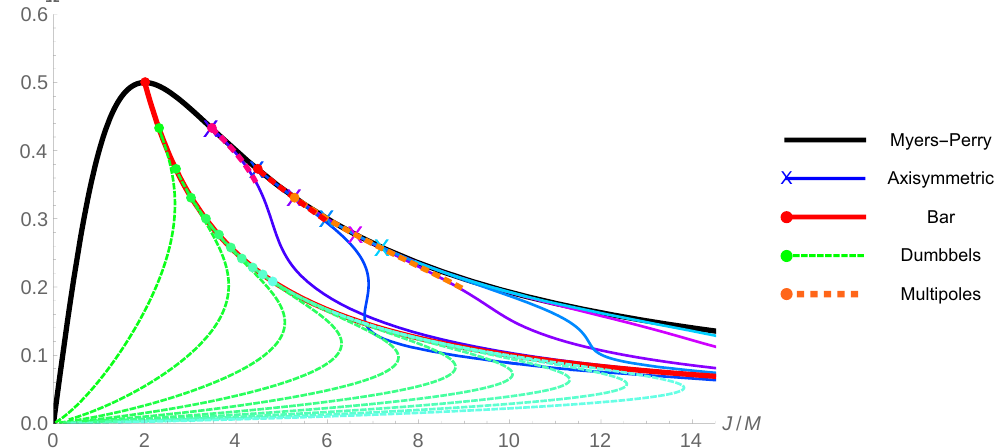
Figure 1 . Phase space plot of the (cid:12)rst appearing branches of solutions with a single angular mo- mentum (per unit mass) J = M and angular velocity (cid:10). In the ultra-spinning regime J = M > 2 the MP-BH develops instabilities and the corresponding zero modes appear at places marked with dots or crosses. For the analytically known black bar, we also study its non-uniform deforma- tions (’dumbbells’), whose branches are shown in di(cid:11)erent shadings of a color to make them more